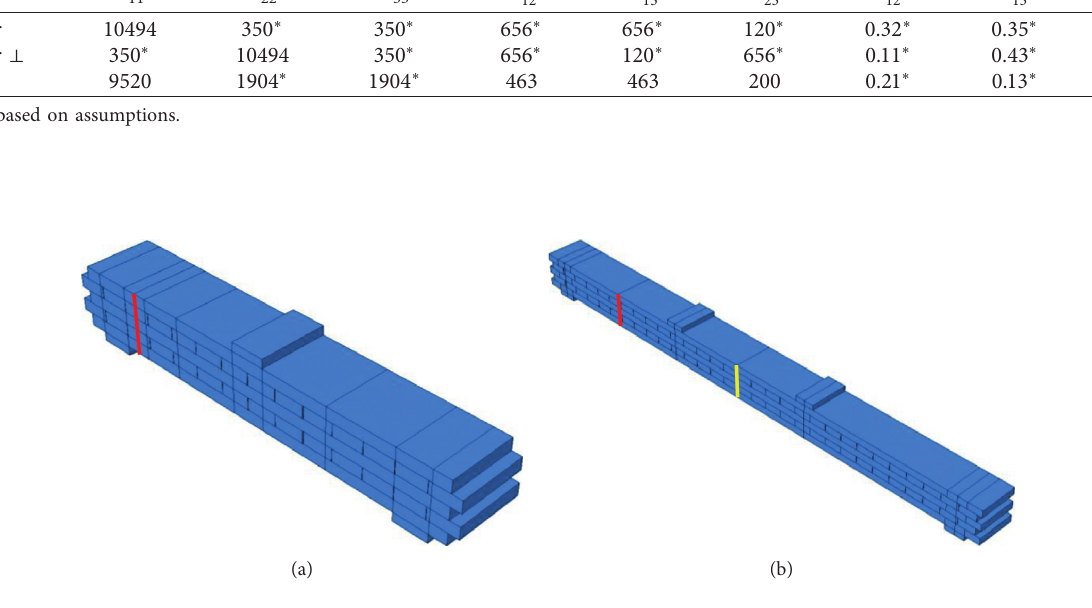
Figure 4: Finite element models for shear and bending of CLT C1 (shear strain location � red lines, bending strain location � yellow